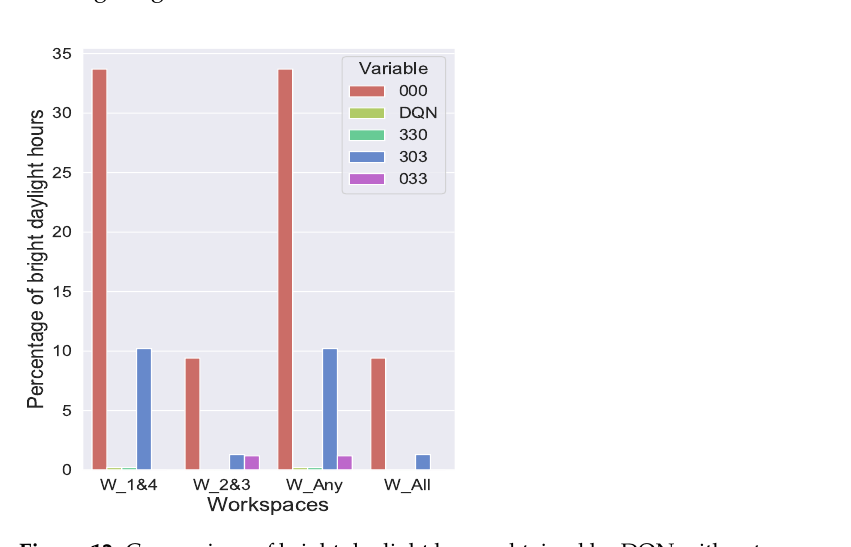
Figure 12. Comparison of bright daylight hours obtained by DQN with extreme cases. Observe the extremely low bright daylight hours for the DQN agent at each of the